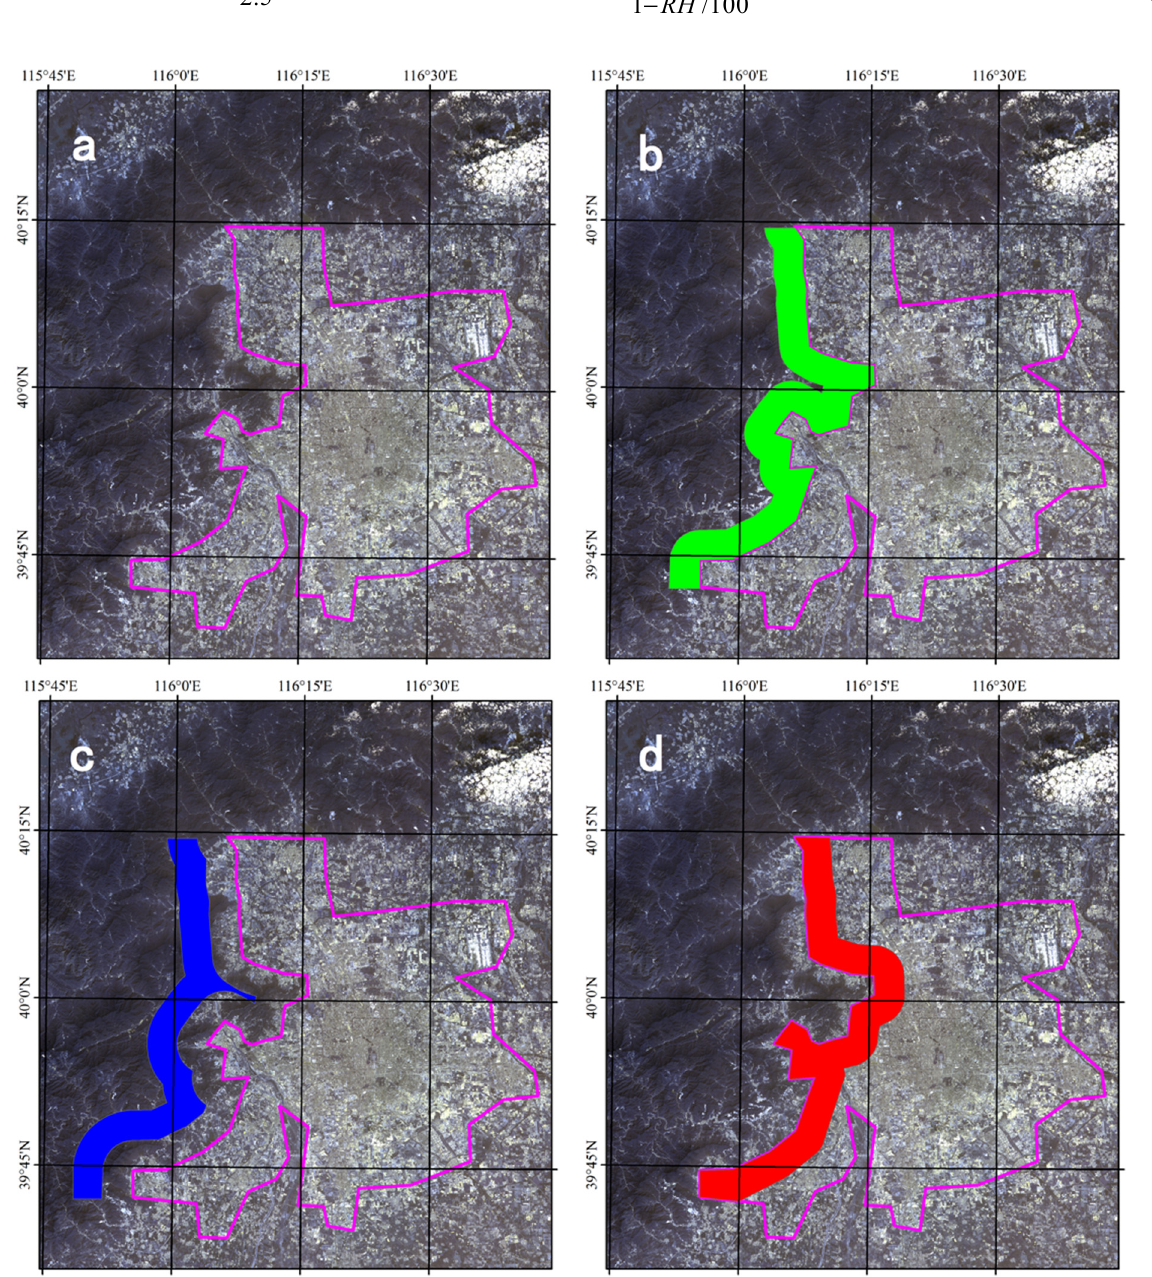
Figure 3. The 4 daily NTL data regions. The purple polygon ( a ) is the urban boundary of Beijing. The green region ( b ) extends westward 5 km from the western boundary of the urban area. The blue region ( c ) extends westward 5 km from the western boundary of area b ( i.e. , between 5 and 10 km from the urban boundary). The red region ( d ) extends eastward 5 km from the western boundary of the urban